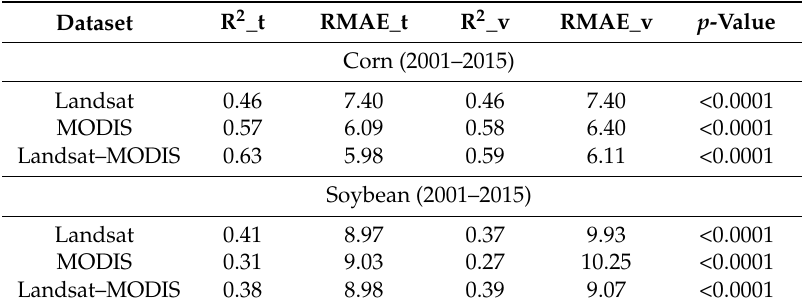
Table 1. The coefficient of determination (R 2 ) and the relative mean absolute error (RMAE) of yields and maximum EVI2 separated by training (_t) and validation (_v) results for corn and soybean (all linear regressions are statistically significant with p -value <